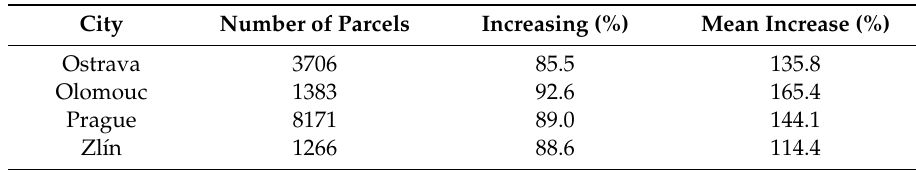
Table 2. Development in land parcels between 2006 and 2019.